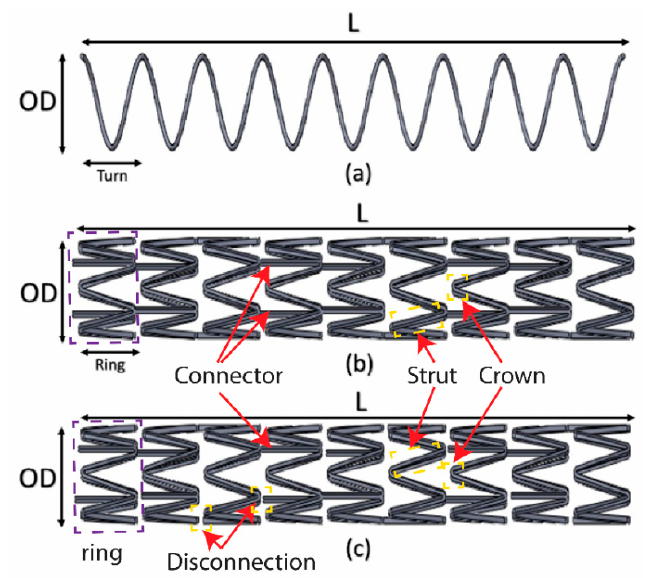
Figure 4. 3D topologies of the final design of ( a ) helical stent, ( b ) regular multi-connector stent, and ( c ) single-connector stent.